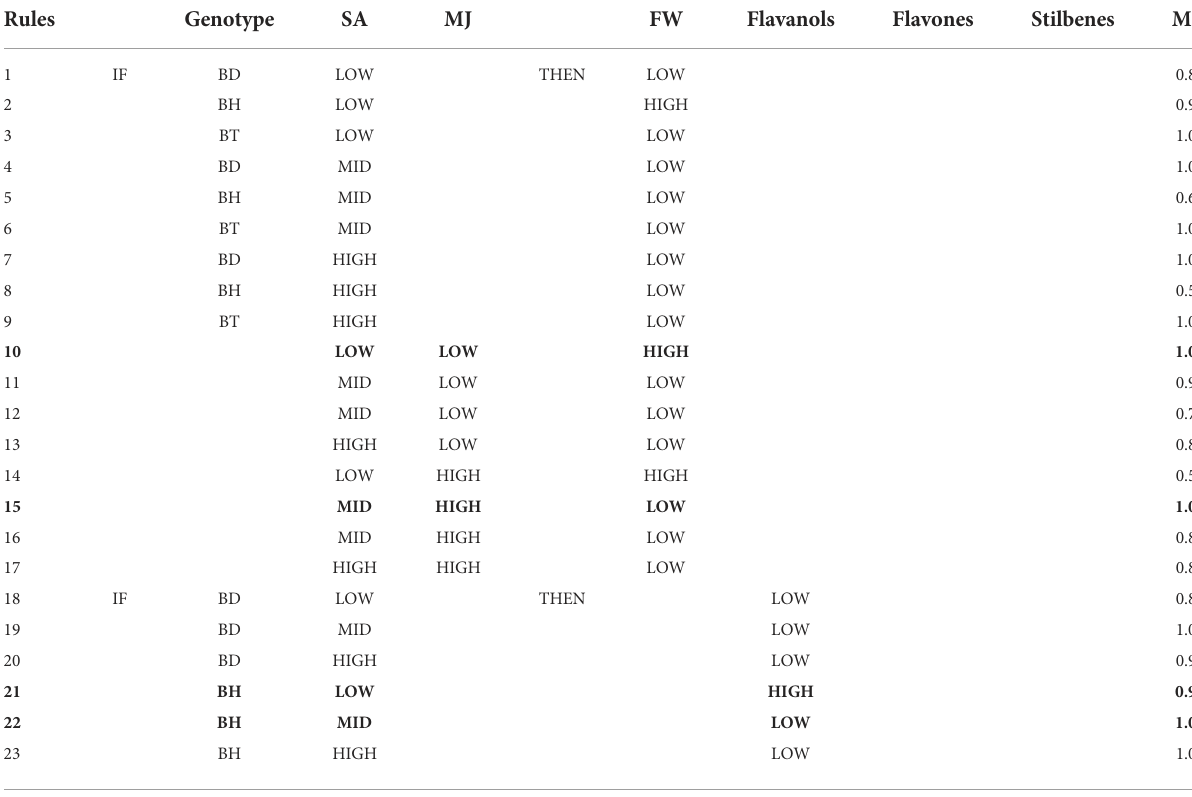
TABLE 4 Complete set of “ IF-THEN ” rules obtained by NFL models with their corresponding degrees of membership (MD).